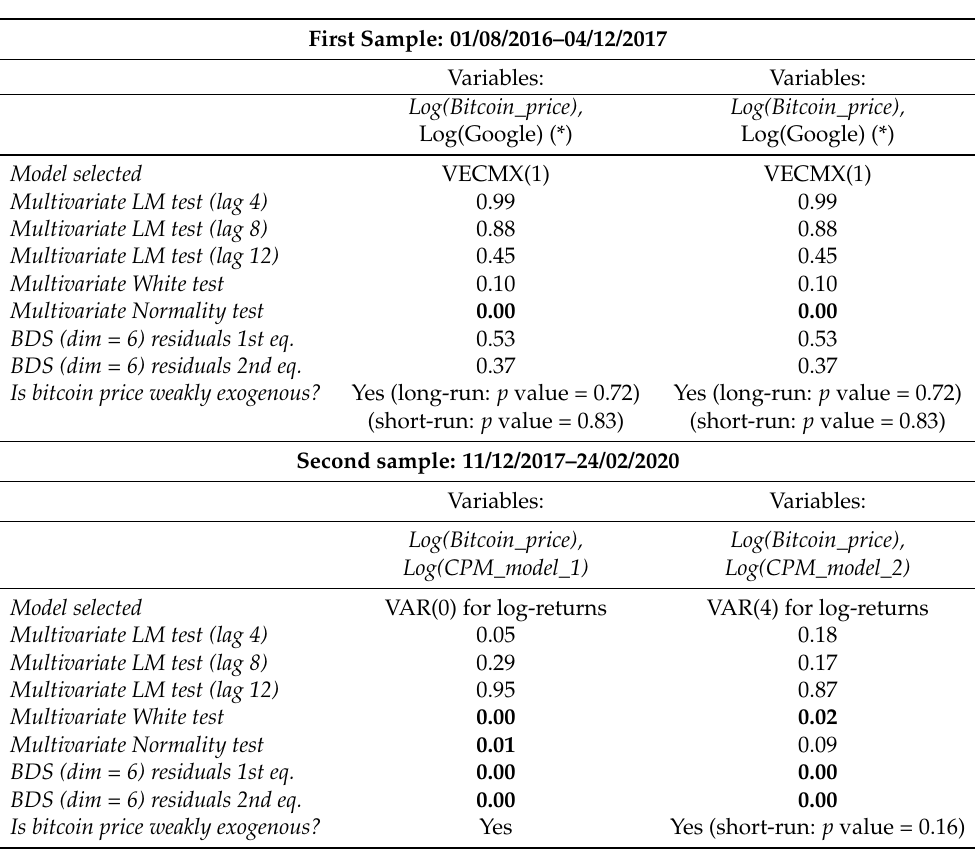
Table A13. Misspecification tests on the residuals from the multivariate models. p -values smaller than 5% are reported in bold font. (*) The final model turned out to be the same, independently of whether we used the CPM1 or the